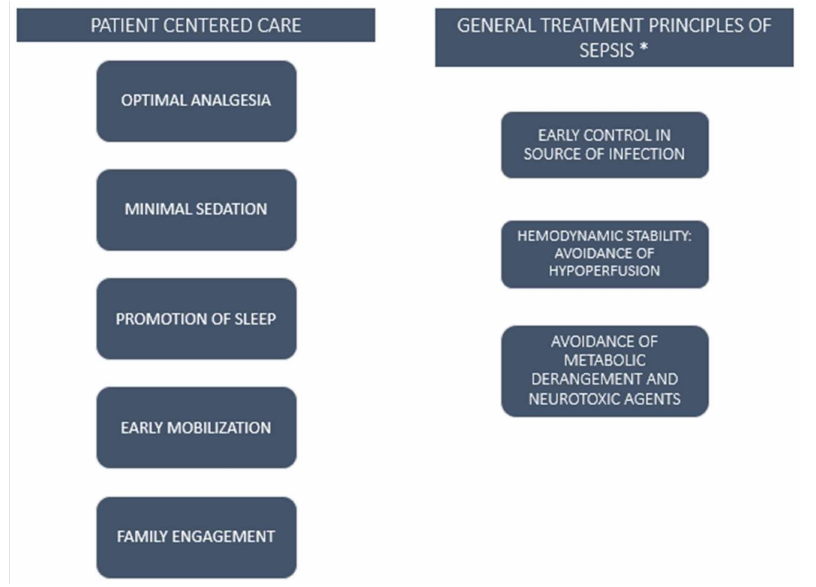
Figure 2. Strategies to prevent sepsis-induced long-term cognitive impairment. * according to recent